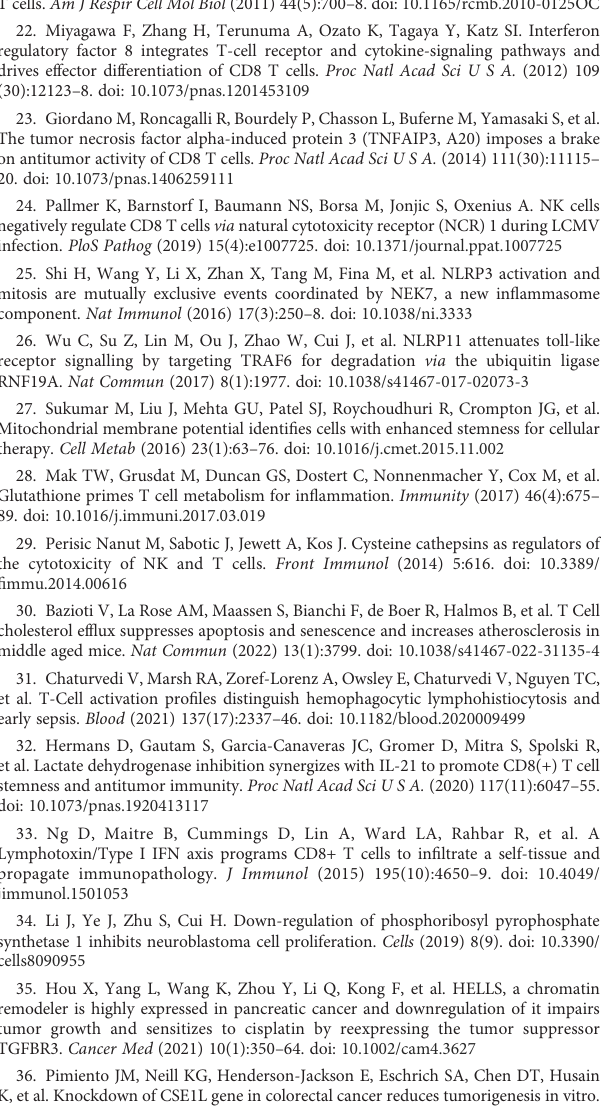
SUPPLEMENTARY FIGURE 4 Leading edge genes in the top pathways identi fi ed by GSEA analysis. Heatmaps demonstrating the top 20 leading edge genes enriched in hallmark gene sets when comparing aIFNg to UnRx (A, B) , ruxolitinib to UnRx (C, D) and combination treatment to UnRx (E, F) .